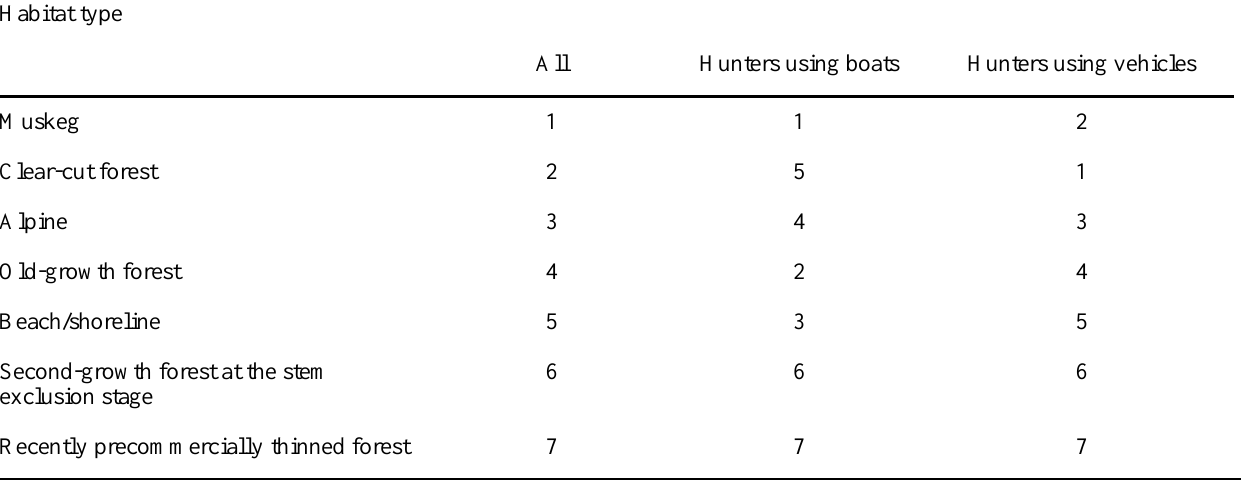
Table 2 . Ranking of preferred deer hunting areas by habitat type according to responses from deer hunters interviewed on Prince of Wales Island, Alaska. A ranking of 1 indicates the most popular habitat; 7, the least